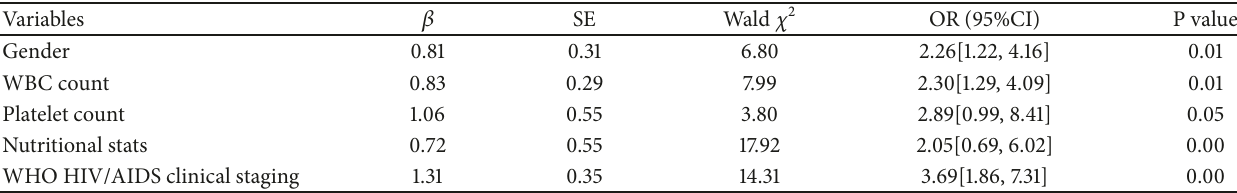
Table4:LogisticregressionanalysisshowingtheassociationbetweenpatientcharacteristicsandanemiaamongpeoplelivingwithHIV/AIDS (n =